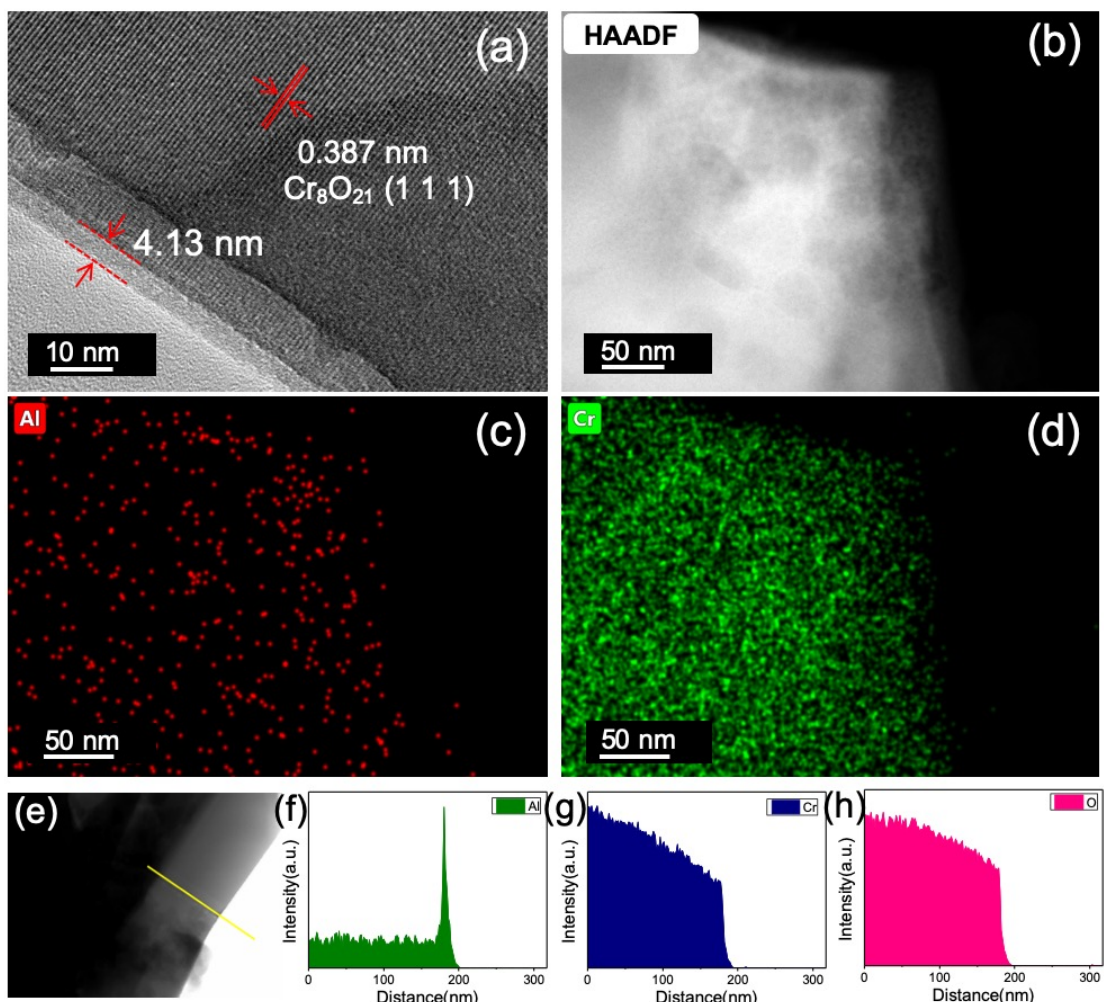
Figure 2. ( a ) TEM image of the Cr 8 O 21 electrodes with 12 cycles of Al 2 O 3 ALD, ( b ) TEM image of the EDS mapping region, ( c , d ) EDS mapping of Al and Cr, ( e ) line scan position of STEM-EDS, and the line scan results of ( f ) Al, ( g ) Cr and ( h ) O.